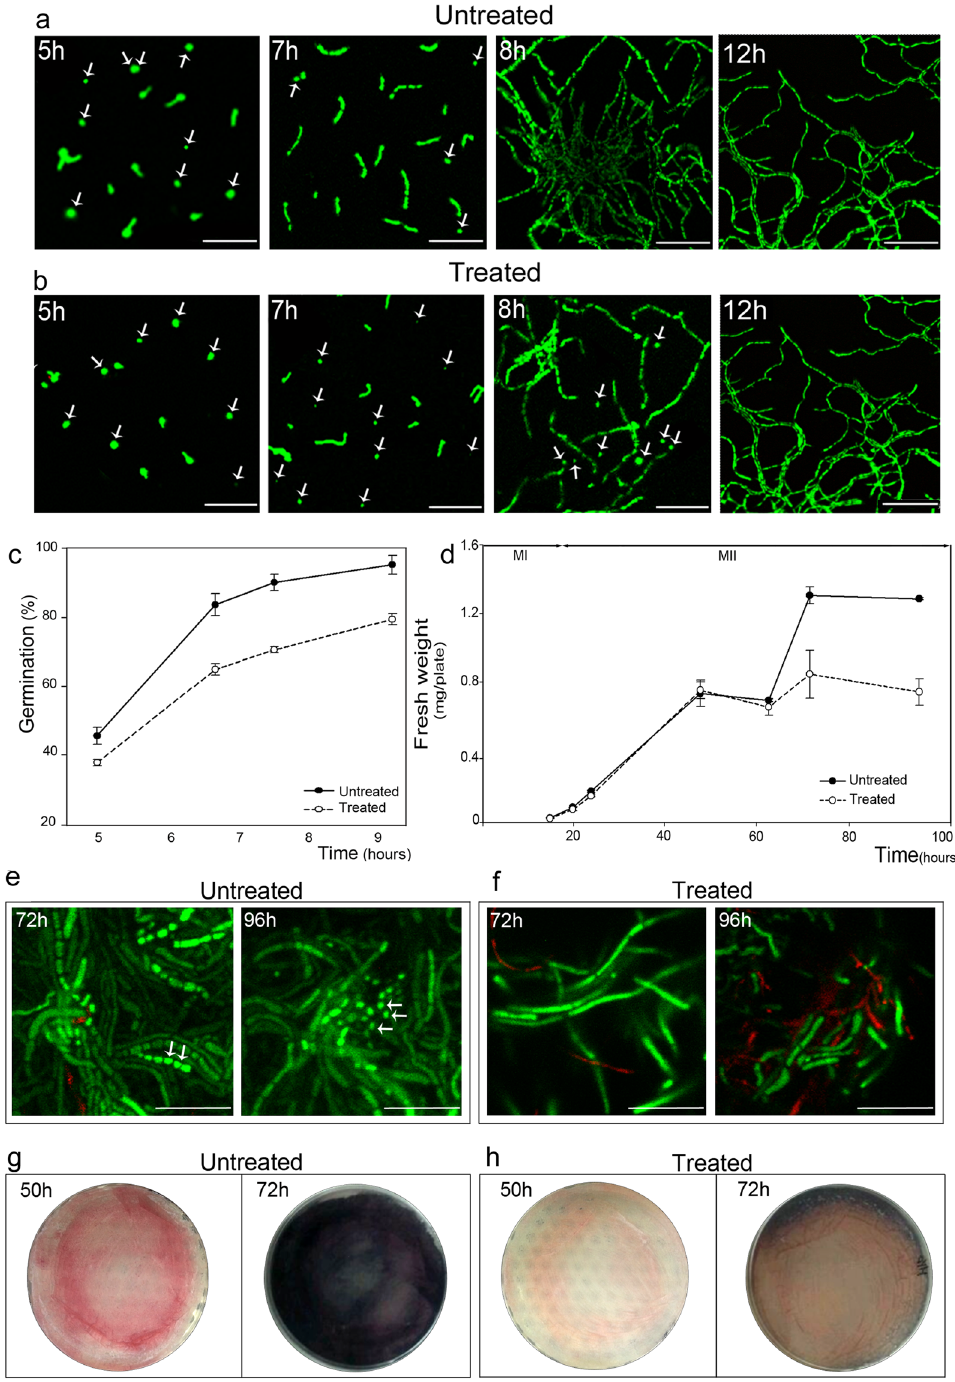
Figure 2. Effect of 5-aza-dC treatment on S . coelicolor morphological and physiological differentiation on solid GYM. ( a , b ) CLSM analysis (LIVE/DEAD Bac-Light bacterial viability kit staining) of the untreated and treated cultures after 5, 7 and 8h from seeding of the same spore stock on GYM plates with or without 5-aza-dC. ( c ) Percentage of spore germination after 5 h, 7 h, 8 h and 9 h of growth of untreated and treated cultures. ( d ) Growth curves of untreated and treated cultures. ( e , f ) CLSM analysis of untreated and treated cultures at 72 and 96 h. ( g , h ) Macroscopic view of undecylprodigiosin (red color) and actinorhodin (blue color) production of untreated and treated cultures at 50 and 72 h on GYM